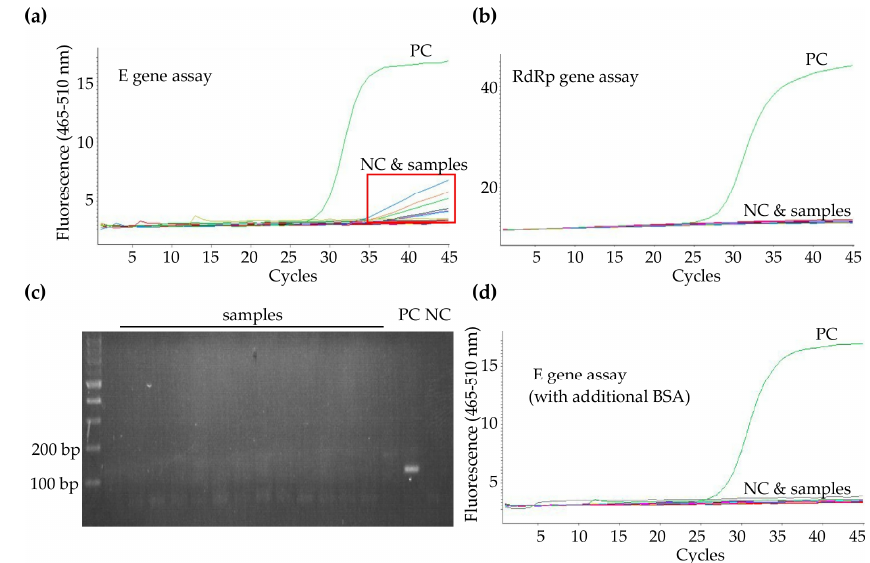
Figure 2. Verified and solved nonspecific fluorescent signal for E gene assay. ( a ) Nonspecific fluorescence signal in the late cycles of late cycles (red rectangle) in E gene assay; ( b ) Amplification curve without nonspecific fluorescence signal in RdRp gene assay; ( c ) Verified the PCR products of E gene assay by gel electrophoresis and only the positive control sample showed a band with the correct size (expected 112 bp). ( d ) The nonspecific fluorescence signal reduced after adding 1 mg/mL of bovine serum albumin (BSA) to the reverse transcriptase polymerase chain reactions (PCR).